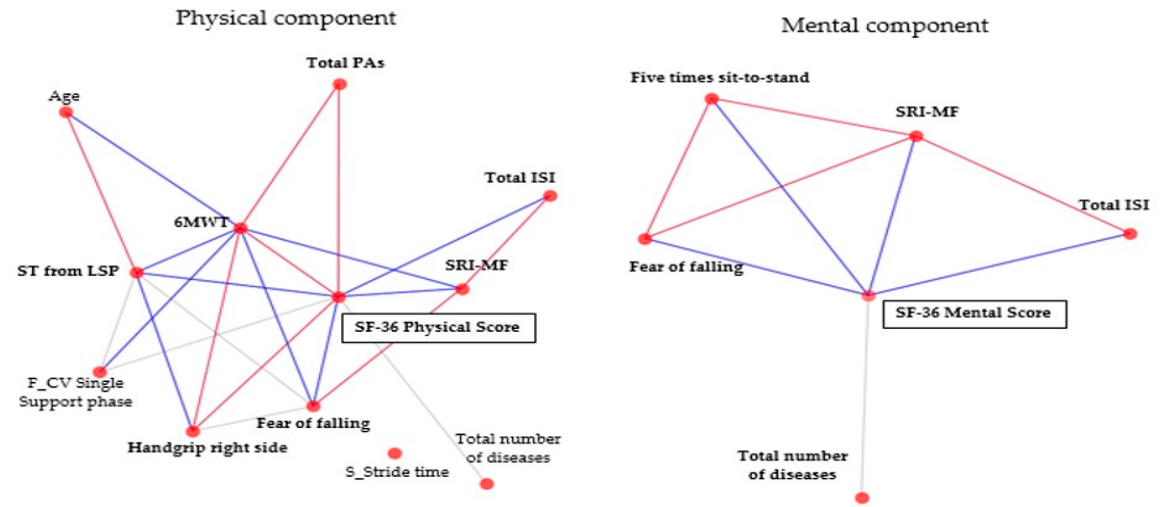
Figure 6. Network analysis of the edges based on the Pearson correlation. Edges in black, red, and blue represent |0.2| < r < |0.25|, r ≥ 0.25, and r ≤ − 0.25, respectively.